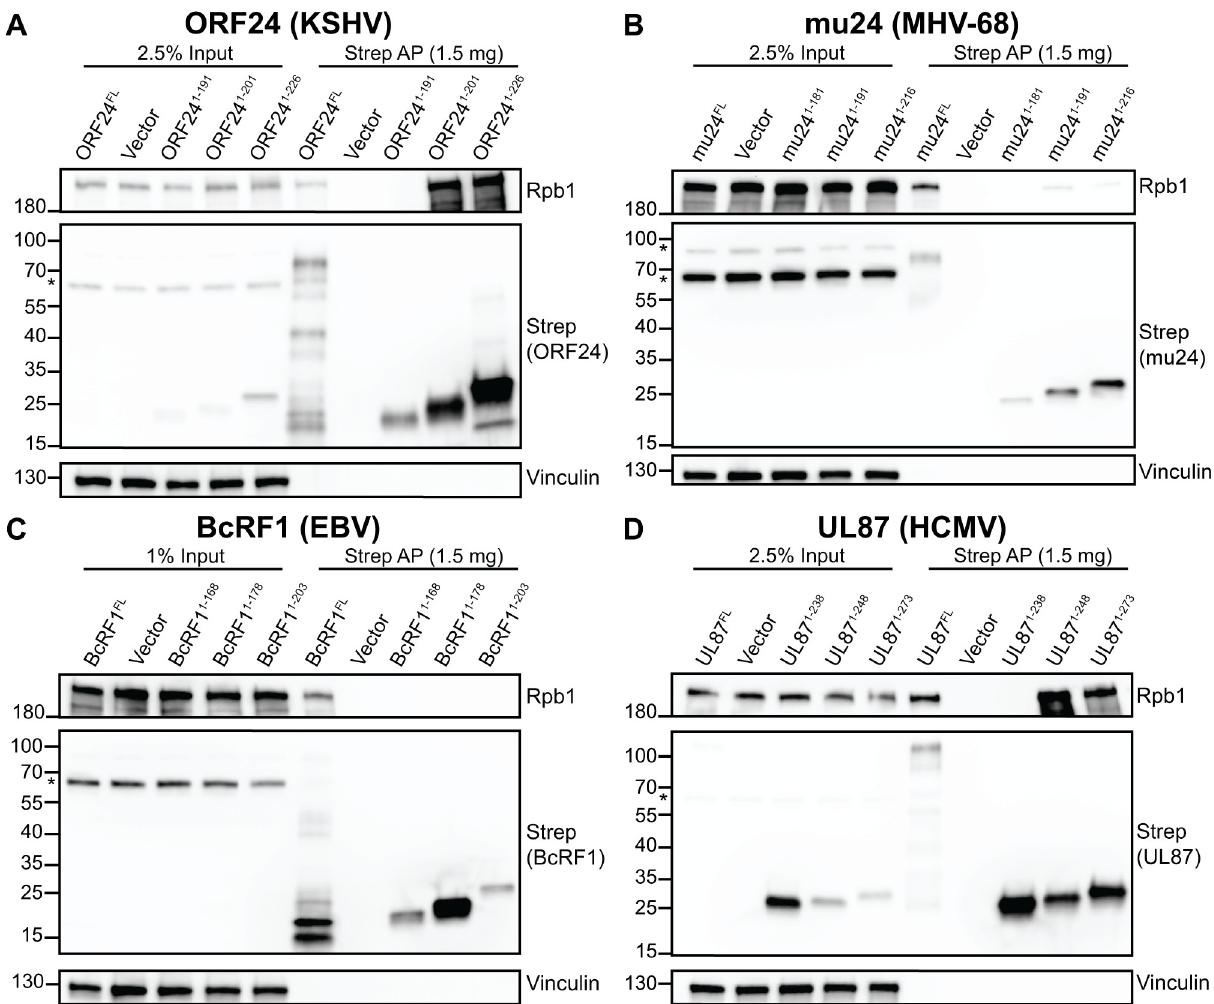
Fig 3. The N-terminal domain of ORF24 homologs from other β - and γ -herpesviruses is sufficient for interaction with Pol II. (A-D) Full-length or truncated Strep-tagged constructs of ORF24. (A) or homologs from MHV68 (mu24; B), EBV (BcRF1; C), and HCMV (UL87; D) were transiently transfected into HEK293T cells then co-affinity purified (AP) with StrepTactinXT beads followed by western blotting. ( � ) indicates the presence of a non-specific band seen while using the anti-Strep